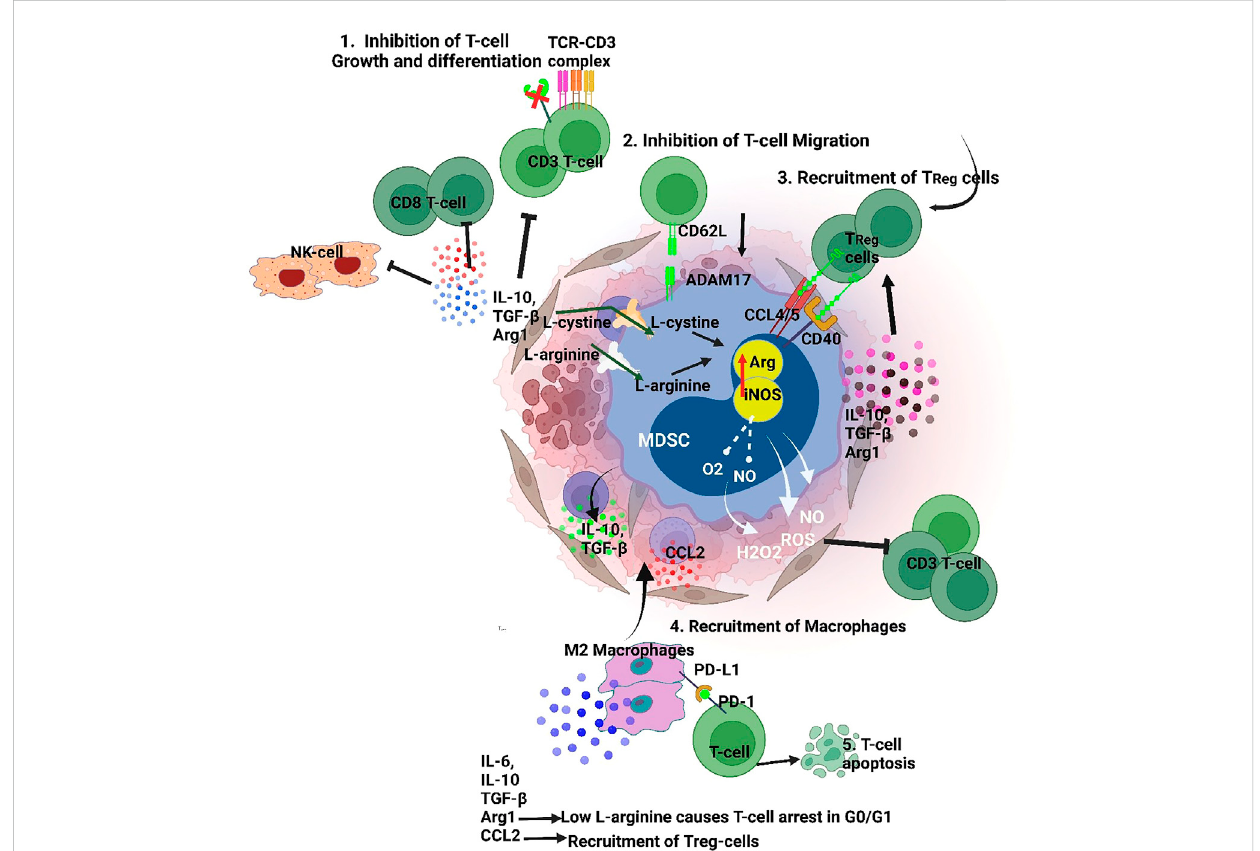
FIGURE 1 MDSCs suppressive mechanism targets both innate and adaptive immunity 1. Targeting T cell and NK cell function by TGF β /IL10 induced inhibition. Also, MDSCs release ROS, H 2 O 2 and peroxynitrite which dysregulate the TCR Z chain inhibiting T-cell/MDSC interaction 2. MDSCs maintain a pre- metastatic niche inhibiting T-cell migration, 3. MDSCs interact with Tregs via CCL4/5 and CD40 that recruitments them to the TME, 4. MDSCs induce a M2 macrophage phenotype by secretion of IL-10, thereby promoting immune escape for tumor cells. Furthermore, secretion of factors like IL-10 and TGF-b, and reduction of L-arginine by MDSCs induce Treg polarization. (iNOS-Inducible nitric oxide synthase, Arg- Arginase, PD-L1- Programmed death-ligand 1, TGF β - Transforming growth factor beta, IL-10- Interleukin 10, 1L-6- Interleukin 6,CCL-2- C-C Motif Chemokine Ligand 2, CCL4-